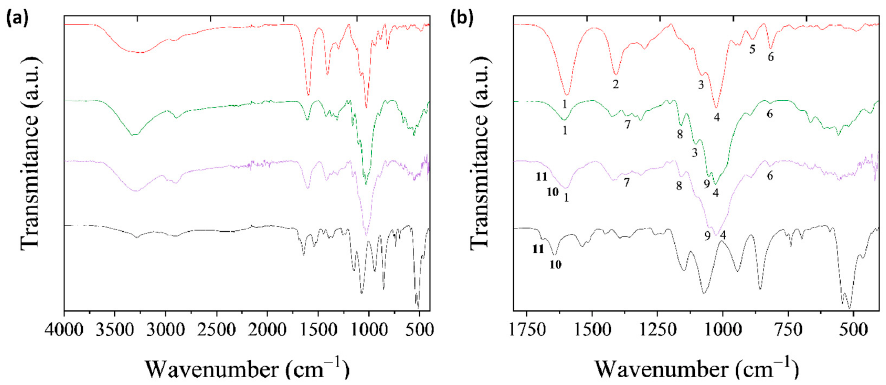
Figure 7. ( a ) The ATR-FTIR spectra of the inks: Alg (red curve), Alg_MCC 40 (green curve), and Alg_MCC 40 _FFY (purple curve), Fmoc-FFY (black curve) and ( b ) zoom-in of the area of interest. Note that the numbers indicate the relevant peaks.